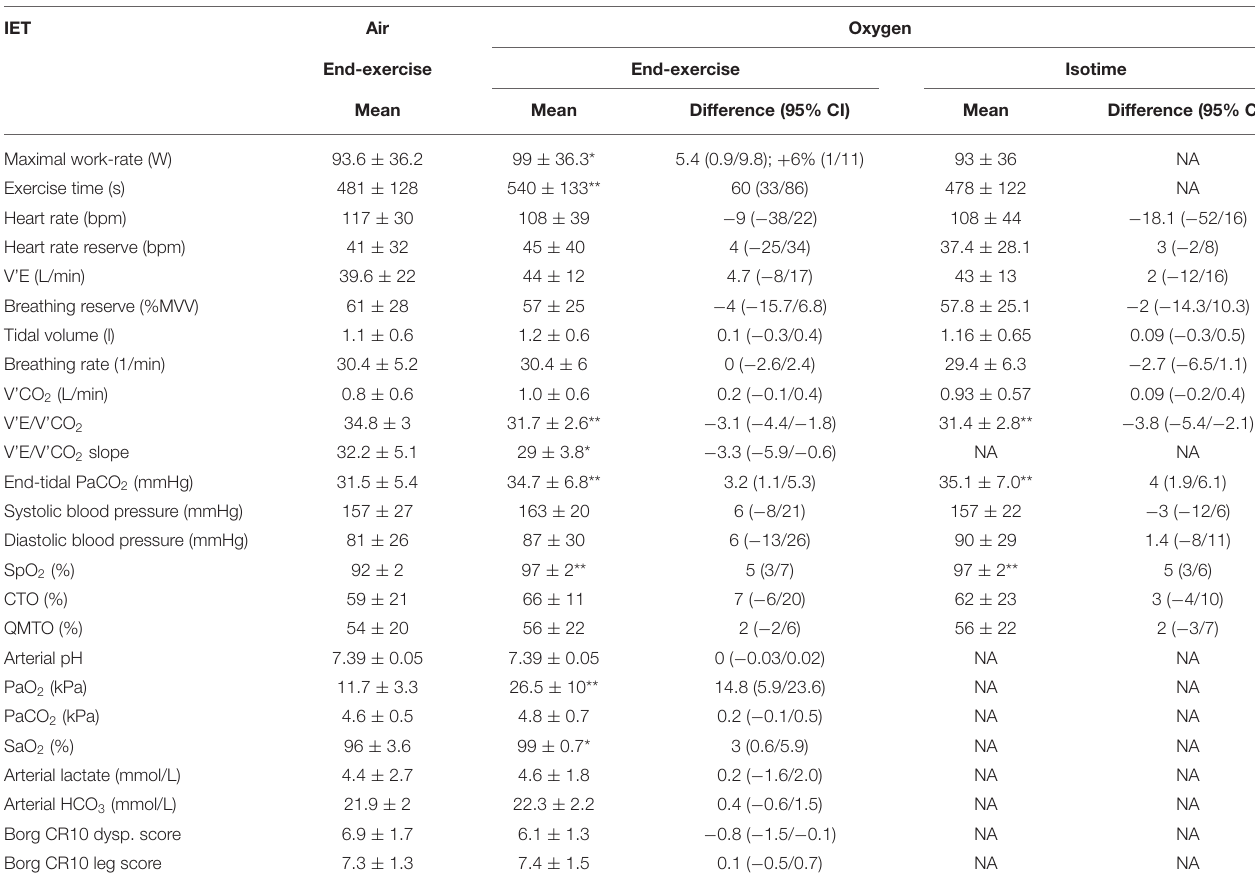
TABLE 2 | Results of the incremental exercise test.